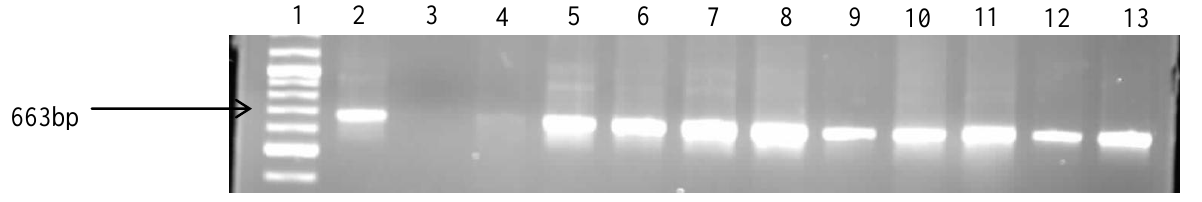
Figure 2. Gel electrophoresis of the PCR products of some of the confirmed Vibrio spp. Lane 1: Gene ruler (100 bp); Lane 2: Positive (+ve) control V. fluvialis ; Lane 3: Negative control; Lane 4–13 (Samples). control; Lane 4–13